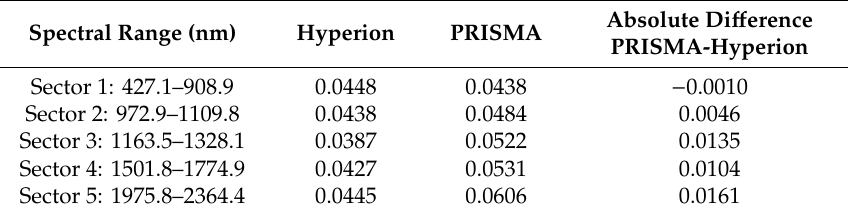
Table 4. Mean reflectance values from Hyperion and PRISMA in the considered spectral sectors; the absolute differences are also reported.